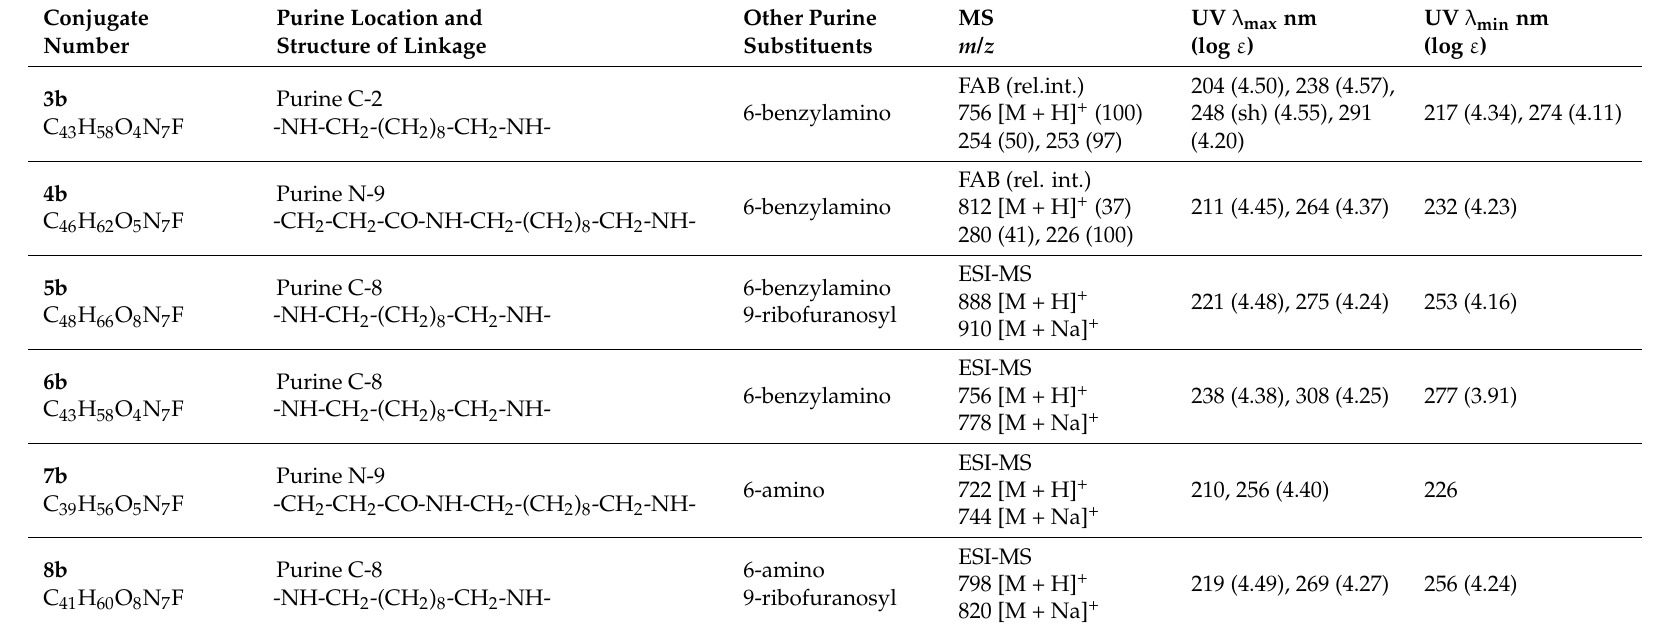
Table 1. List of purine-dexamethasone conjugates showing numbers assigned to compounds and molecular formulae, position and structure of linkages, other purine substituents present and mass spectral and UV characteristics of compounds. UV spectra were determined in 95% ( v / v ) ethanol containing HCl (0.1 M). Accurate m / z values for M + H molecular ions determined by ESI-MS are listed in a footnote. Calc. denotes the calculated value A